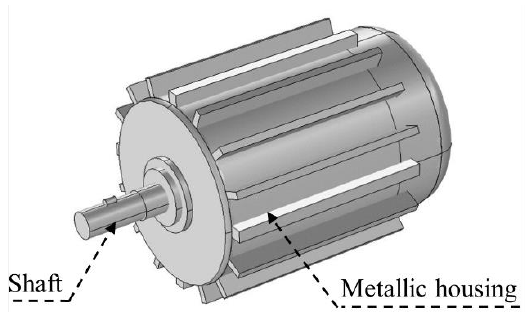
Figure A1. Schematic representation of a typical motor model in electrical vehicles.